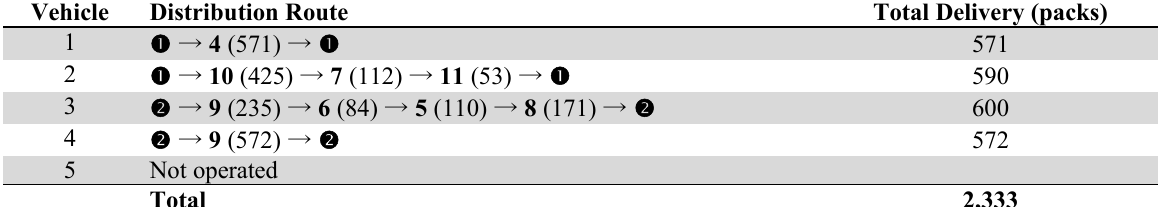
Distribution route and delivery of period